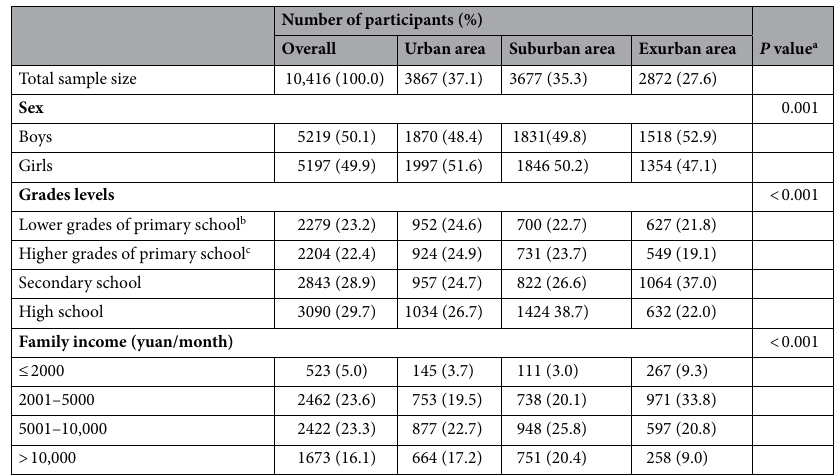
Table 1. Characteristics of students in various regions of Guangzhou during the COVID-19 pandemic. All data are presented as frequency and its percentage. a P values were calculated by Chi-square test. b Lower grades of primary school: grades 1st to 3rd in primary school. c Higher grades of primary school: grades 4th to 6th in primary